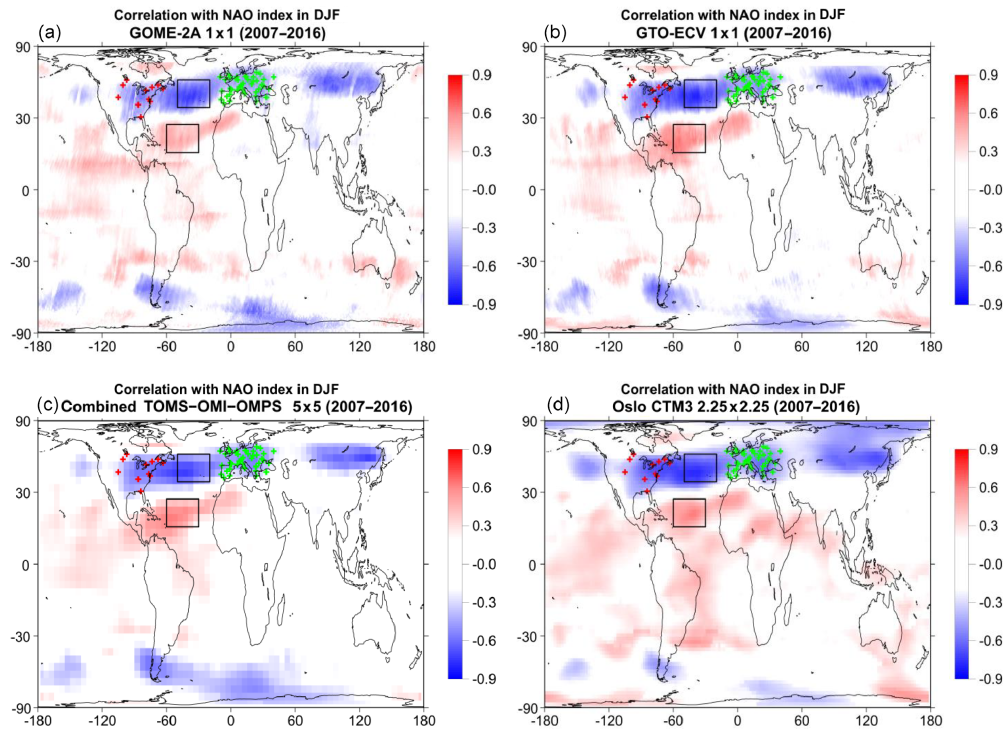
Figure 10. Map of correlation coefficients between total ozone and the NAO index during winter (December, January, and February; DJF) for GOME-2A (a) , GTO-ECV (b) , TOMS–OMI–OMPS satellite data (c) , and Oslo CTM3 model simulations (d) . Rectangles correspond to regions in the North Atlantic (35–50 ◦ N, 20–50 ◦ W; 15–27 ◦ N, 30–60 ◦ W), and red and green crosses correspond to stations in Canada and USA and Europe, where total ozone has been studied as to the impact of NAO after removing variability related to the annual cycle, QBO, solar cycle, and ENSO. Positive correlations are shown by red colours, while negative correlations are shown by blue colours. Only correlation coefficients above or below ± 0 . 2 are